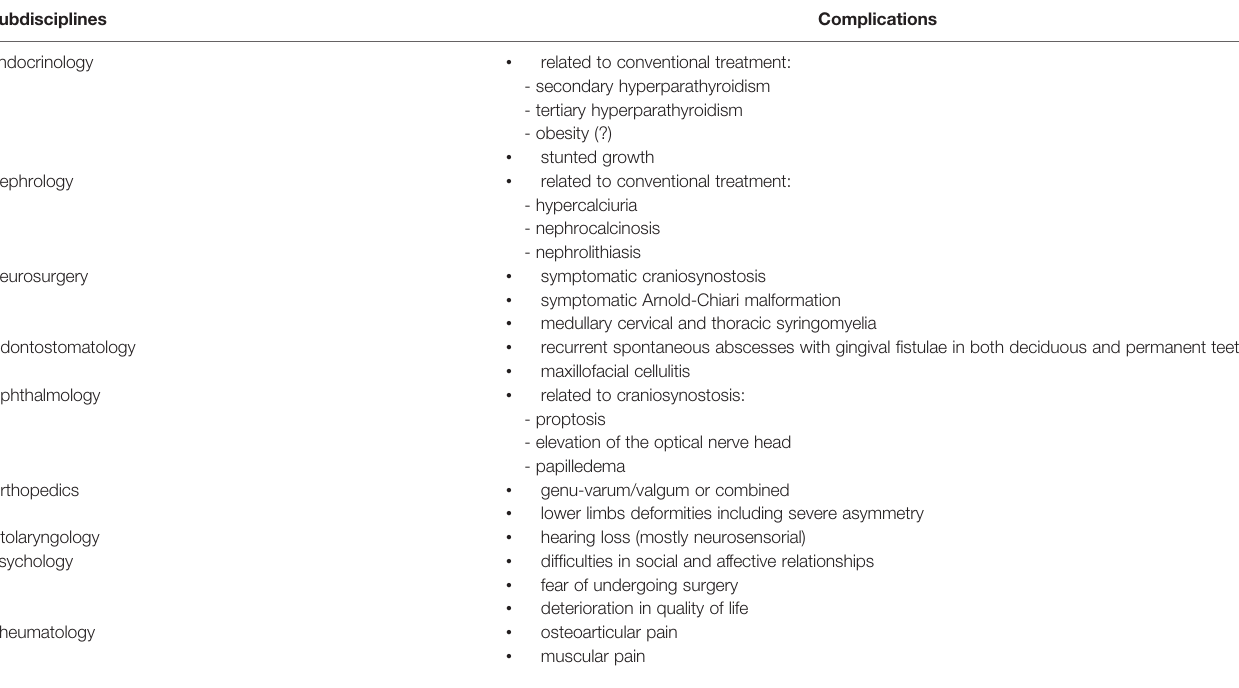
TABLE 3 | Main complications reported in patients with XLH according to specialized subdisciplines (in alphabetic order).